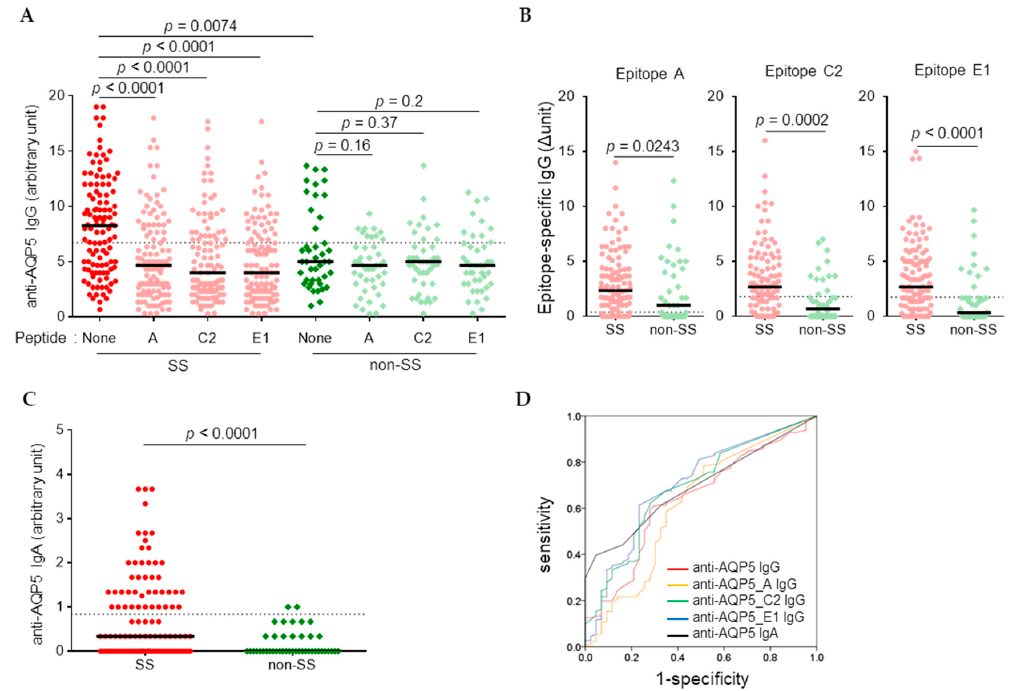
Figure 1. Higher levels of anti-aquaporin 5 (AQP5) IgG and IgA were detected in Sjögren’s syndrome (SS) than in non-SS by cell-based immunofluorescence cytochemistry (CB-IFC). Madin–Darby canine kidney (MDCK) cells overexpressing AQP5 were stained with mouse anti-human AQP5 monoclonal antibodies along with human serum (1:10 for IgA and 1:100 dilutions for IgG) in the absence or presence of epitope peptides, followed by Alexa Fluor 488–conjugated rat anti-mouse IgG and either Alexa Fluor 555–conjugated goat anti-human IgG or Alexa Fluor 594–conjugated rabbit anti-human IgA. ( A ) The intensities of the red signals for anti-AQP5 IgG were expressed by the magnitude of brightness, which was reduced until the staining of AQP5 disappeared. ( B ) The levels of each epitope-specific IgG were determined by subtracting the signal intensities obtained in the presence of epitope peptides from those obtained in the absence of peptide. ( C ) The levels of IgA were expressed by the magnitude of brightness. ( D ) Receiver operating characteristic (ROC) curves of anti-AQP5 IgG and IgA. Dotted lines in graphs A–C present the cut-off values based on the ROC analysis.